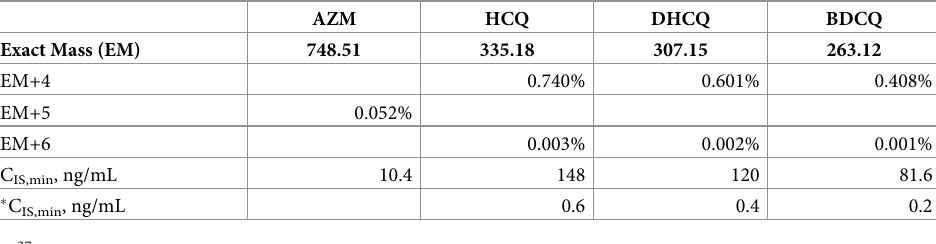
Table 2. Natural abundances of isotopic mass of analytes and minimal IS